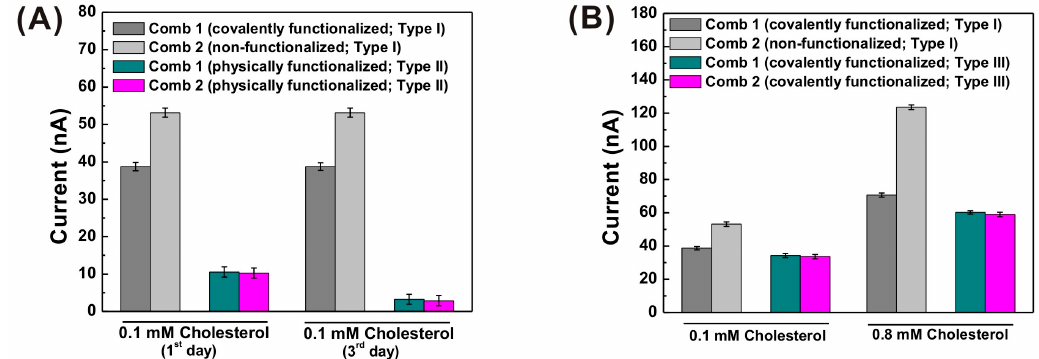
Figure 7. Comparison between chronoamperometric current responses of different types of AuNP/carbon IDEs ( A ) Type I and Type II, ( B ) Type I and Type III in 50 mM PBS containing 10 mM [Fe(CN) 6 ] 3 − (applied potential = 0.6 V vs. Ag/AgCl). Type I: one comb (comb 1) selectively functionalized with ChOx, Type II: all the combs physically functionalized with ChOx, Type III: all the combs covalently functionalized with ChOx.